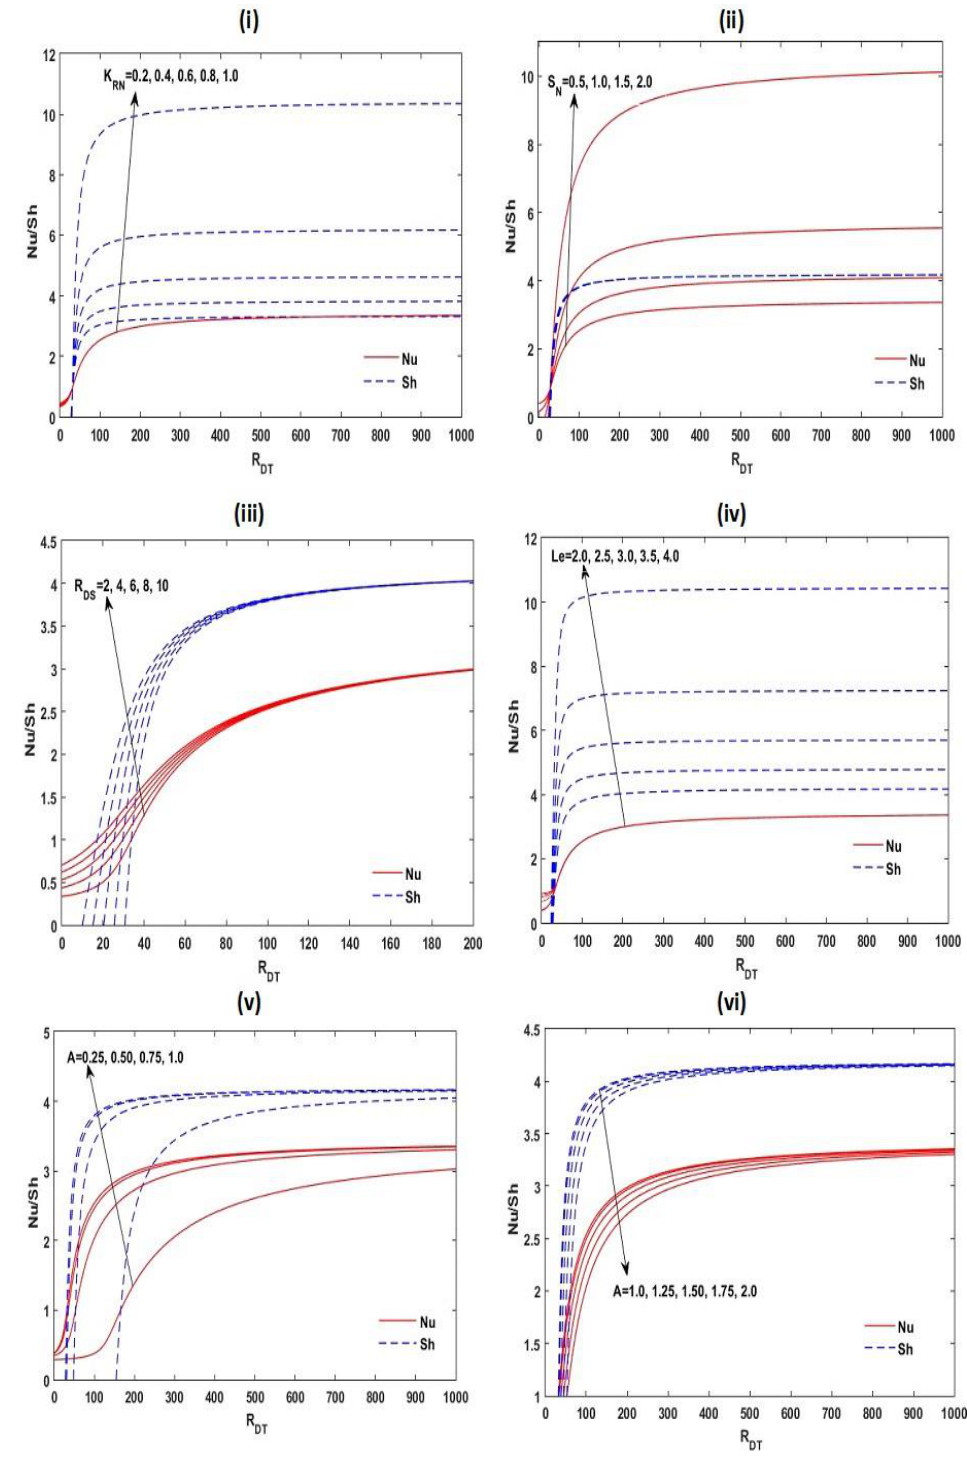
Figure 9. Disparity of the steady Nu and Sh with R DT at Le = 2, A = 1, R DS = 3, S N = 0.5, and K RN = 0.5 for different values of one of these parameters.